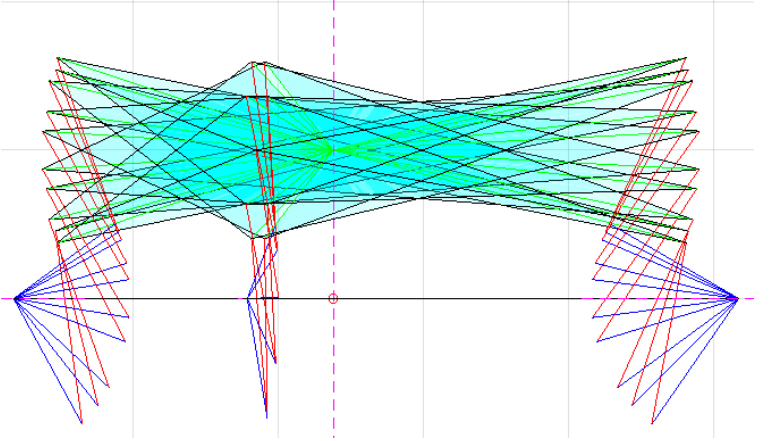
Figure 18. Multi-axis motion platform trajectory model.